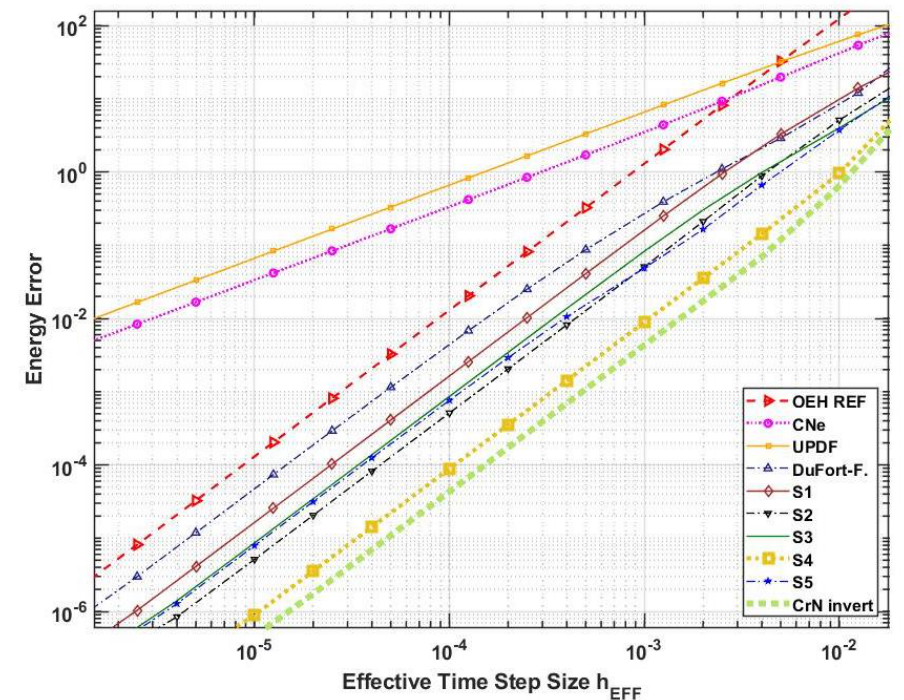
Figure 3. Energy errors as a function of the effective time step size for the first (moderately stiff) system, in the case of the original OEH method (OEH REF), the original one-stage CNe and UPFD method, the new algorithms S1–S5, and the Crank–Nicholson method. For the detailed description of the algorithms, see Sections 2 and 3.2.